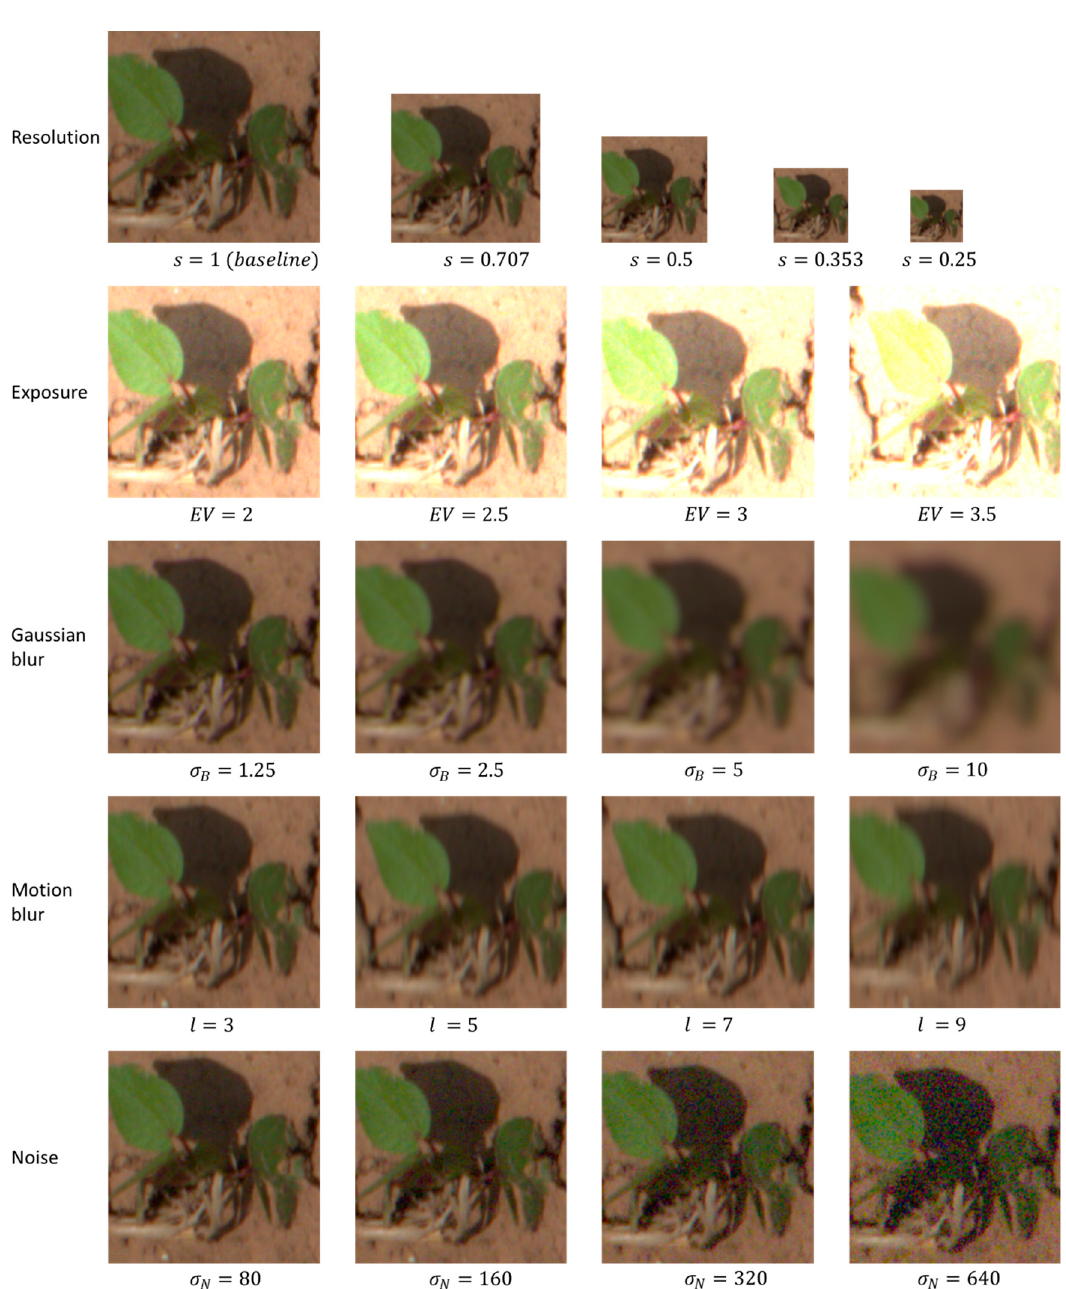
Figure 5. Zoomed-in view of simulation results for resolution, exposure, Gaussian blur, motion blur, and noise.